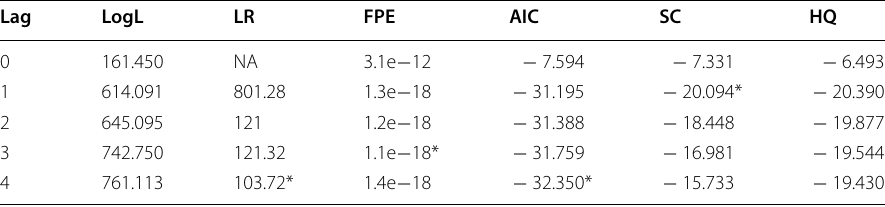
* indicates lag order selected by the criterion